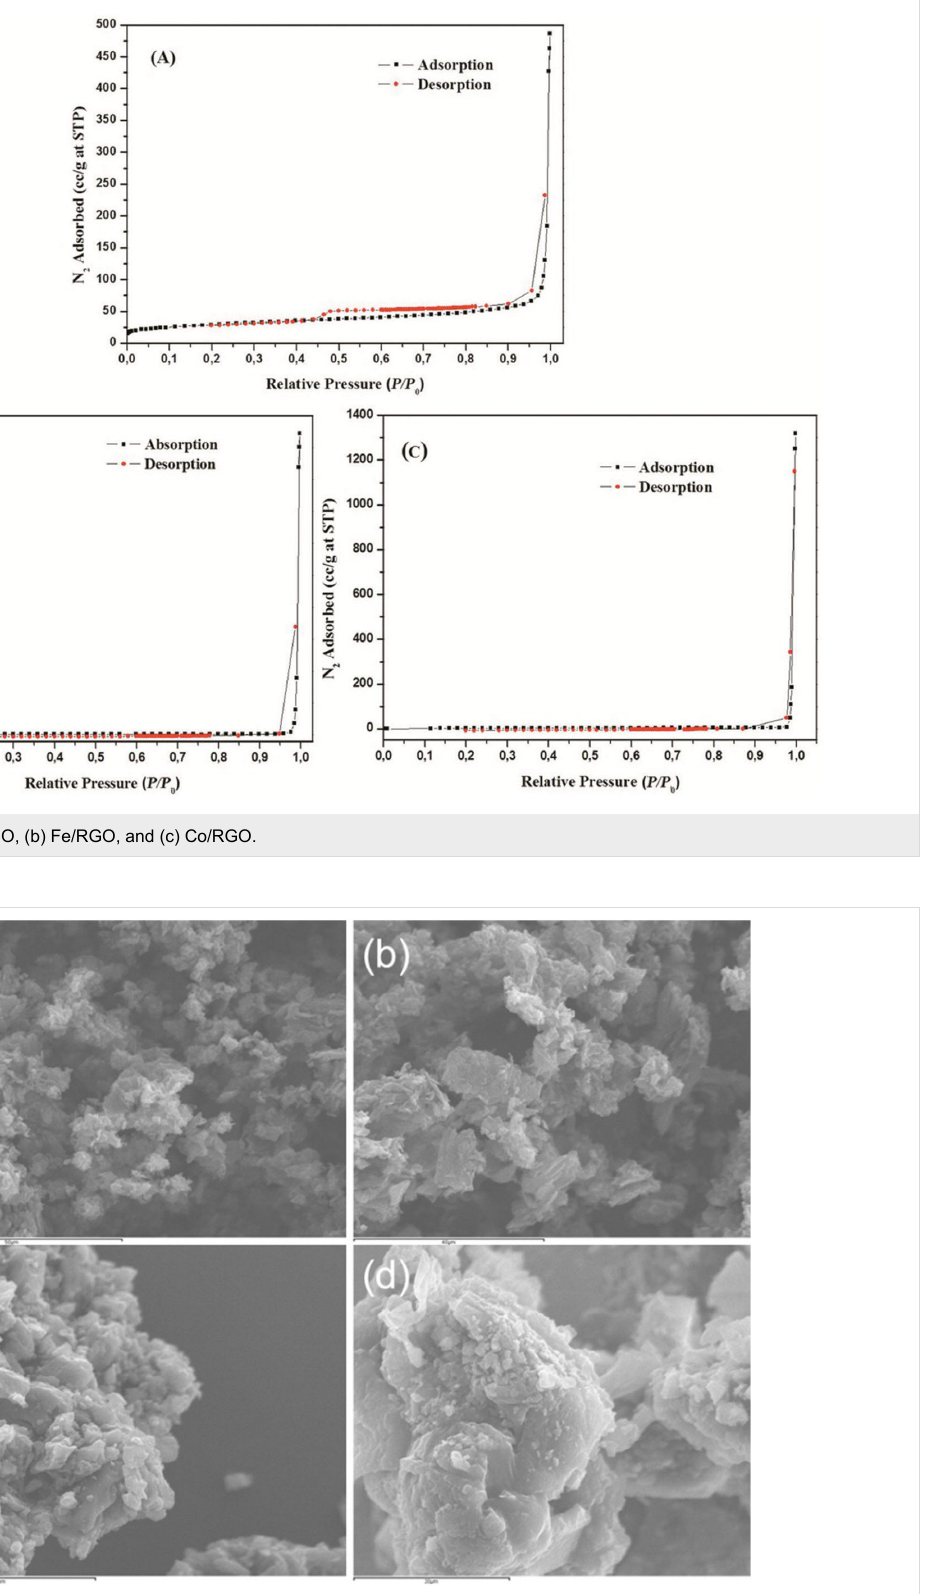
Figure 2: SEM images of (a and b) RGO, (c) 1% Fe/RGO, and (d) 1%